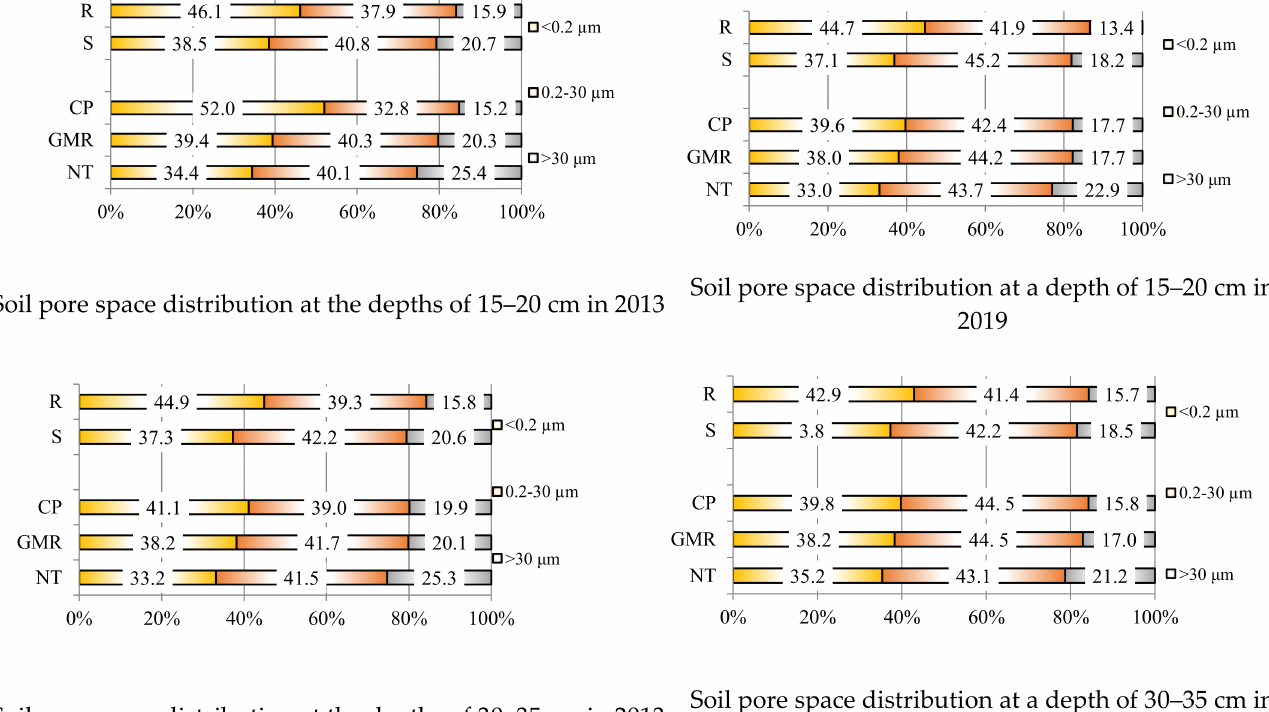
Figure 1. Soil pore space distribution (the content of micropores, mesopores, and macropores as a percentage of total porosity) at the depths of 5–10 cm, 15–20 cm, and 30–35 cm in 2013 and 2019. Notes: No significant differences at p > 0.05; Fisher LSD test vs. control. Other explanations are given in Table